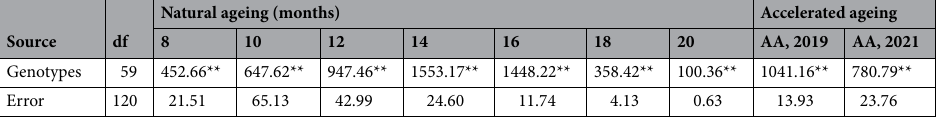
Table 2. Mean sum of squares of seed germination percentage in different soybean genotypes after natural and accelerated ageing. Significance codes: **p = 0.01.